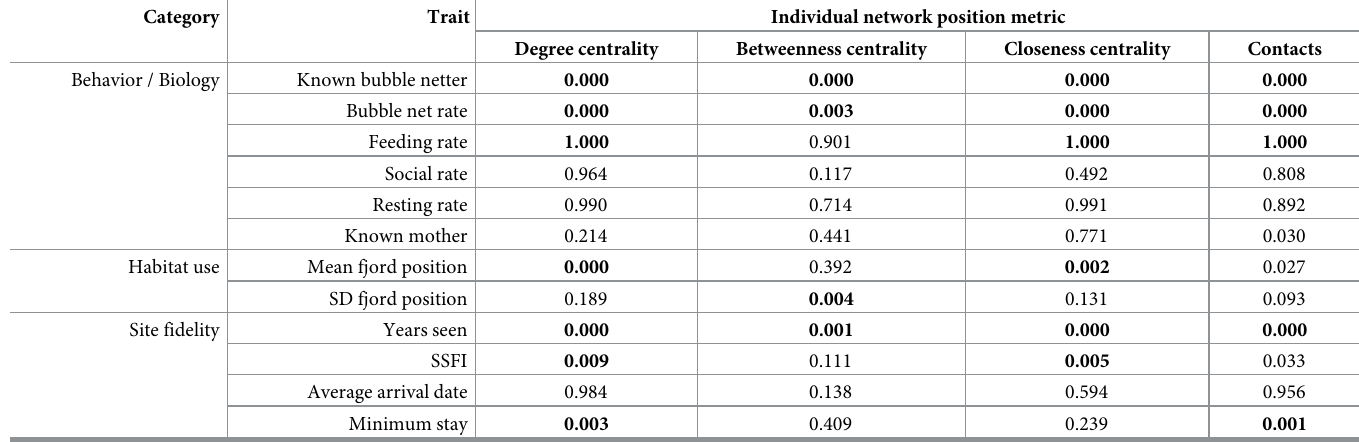
P-values represent the proportion of randomizations for which the slope coefficient of the regression (Position metric ~ Trait) that is greater than the real observed value. Based on a two-tailed test with α = 0.05, P-values below 0.025 (bold) indicate that the relationship between the position metric and the trait is significantly stronger than expected. P-values (also bold) that are greater than 0.975 indicate that the relationship is significantly weaker than